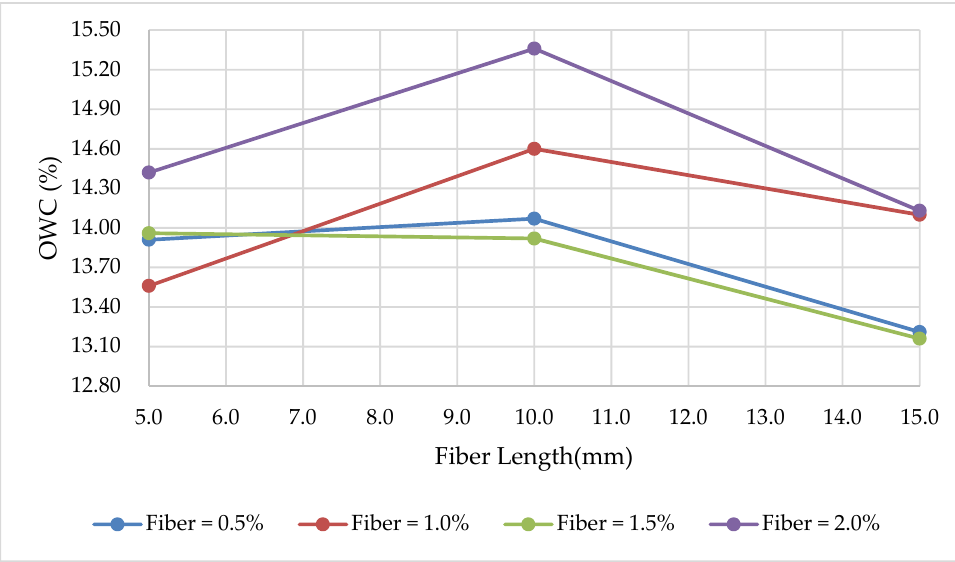
Figure 8. Levels of optimum water contents relative to percentage of fiber length.